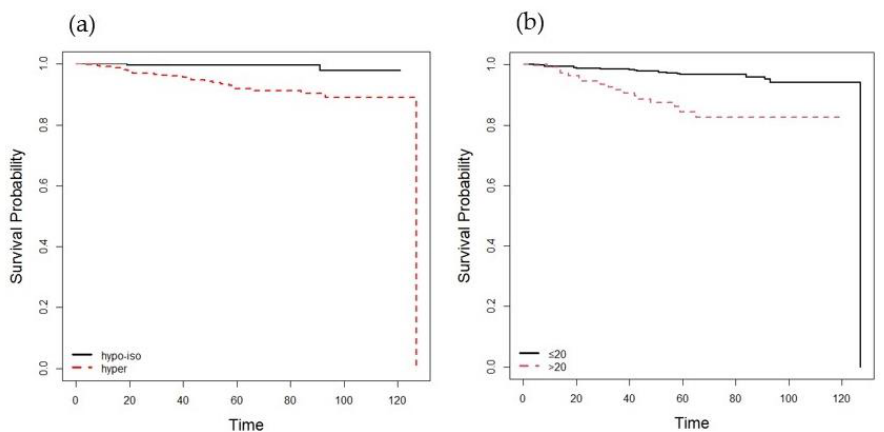
Figure 2. Kaplan-Meier cumulative event curves for recurrence in N1b papillary thyroid carcinoma ( a ) in patients with iso- or hypoechoic vs. hyperechoic LNs (log-rank statistic, p < 0.0001) and ( b ) in patients with LNs larger than 20 mm vs. LNs 20 mm or less (log-rank statistic, p < 0.0001). LN, lymph node.